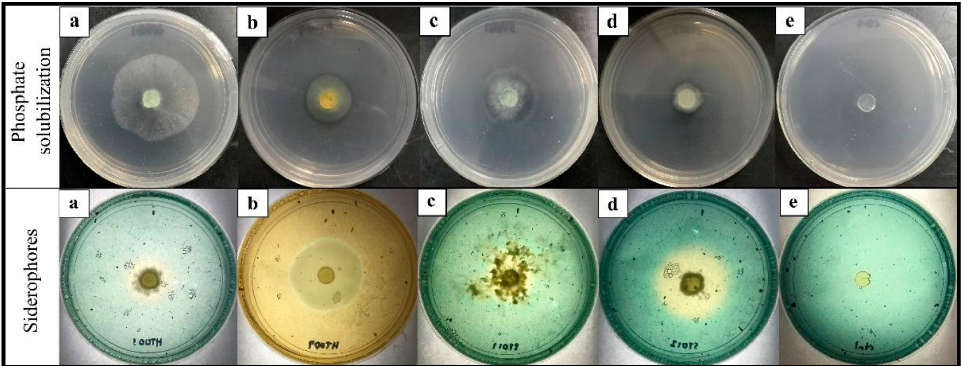
Figure 4. Colorimetric detection of phosphate solubilization and siderophores production by Tri- choderma isolates. ( a ) T. koningiopsis HT001, ( b ) T. spirale HT009, ( c ) T. asperellum ST011, ( d ) T. reesei ST013, and ( e ) the control plate on the Pikovskaya (top row) and the chrome azurol S (bottom row) agar medium. The halo zone on the Pikovskaya agar plate around the colony indicates phosphate solubilization. The formation of an orange zone around the colony growing on the chrome azurol S agar indicates siderophores